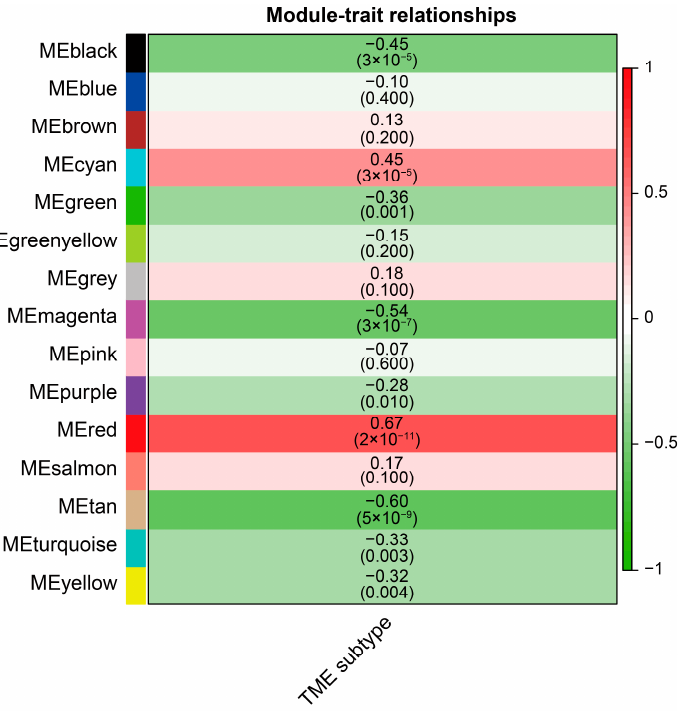
Figure 13. The process of determining an optimal soft threshold. ( A ) Change of the scale-free topological fit index R 2 for different soft threshold. ( B ) Change of the mean connectivity for different soft threshold.